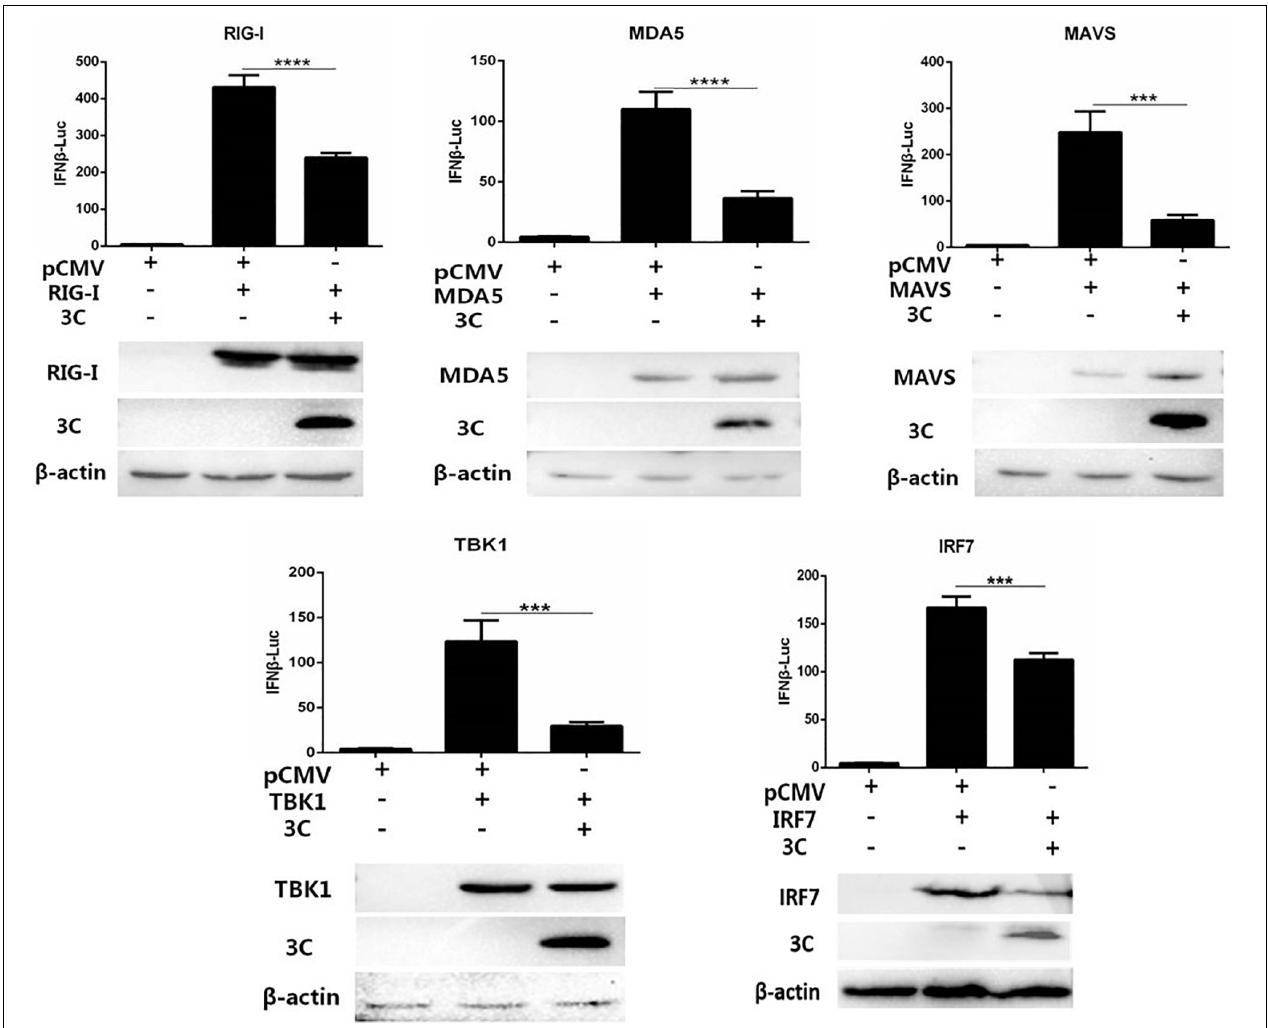
FIGURE 3 | Through the IRF7 protein, the 3C protein inhibits the IFN- β signaling pathway. pCAGGS-MDA5-Flag, pCAGGS-RIG-I(N-terminal)-Flag, pCAGGS-MAVS-Flag, pCAGGS-TBK1-Flag, and pCAGGS-IRF7-Flag were combined with pCMV-3C-HA and IFN- β pro-Luc, and the reference plasmid pRL-TK and cotransfected into DEFs (the transfection ratio of the first three plasmids was 1:3:1, and the amount of pRL-TK transfected was 1/20 that of IFN- β pro-Luc). Six hours after transfection, cell samples were collected. The dual-luciferase reporter system was used to detect IFN- β promoter activity and screen target molecules through which the 3C protein inhibits the pathway upstream of IFN- β . *** P < 0.001, **** P < 0.0001, compared with control